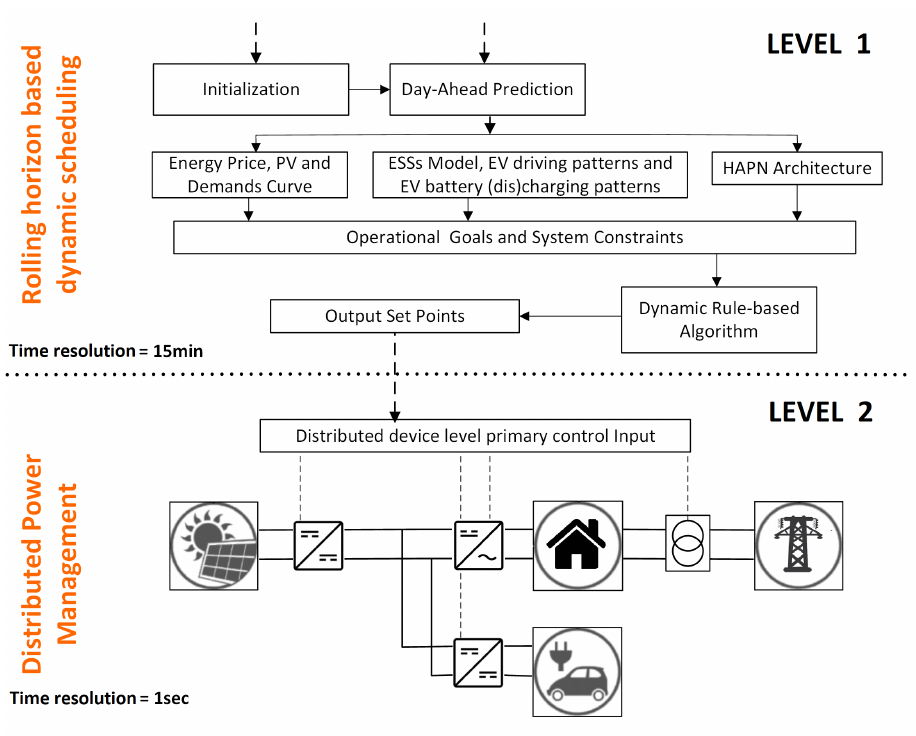
Figure 1. Proposed iEMS